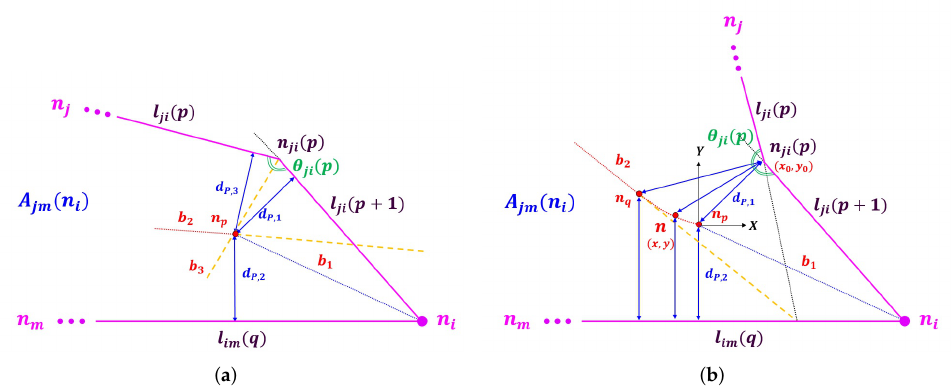
Figure A1. Construction of projection boundary in map area A jm ( n i ) with ( a ) θ ji ( p ) < 180° and ( b ) θ ji ( p ) >